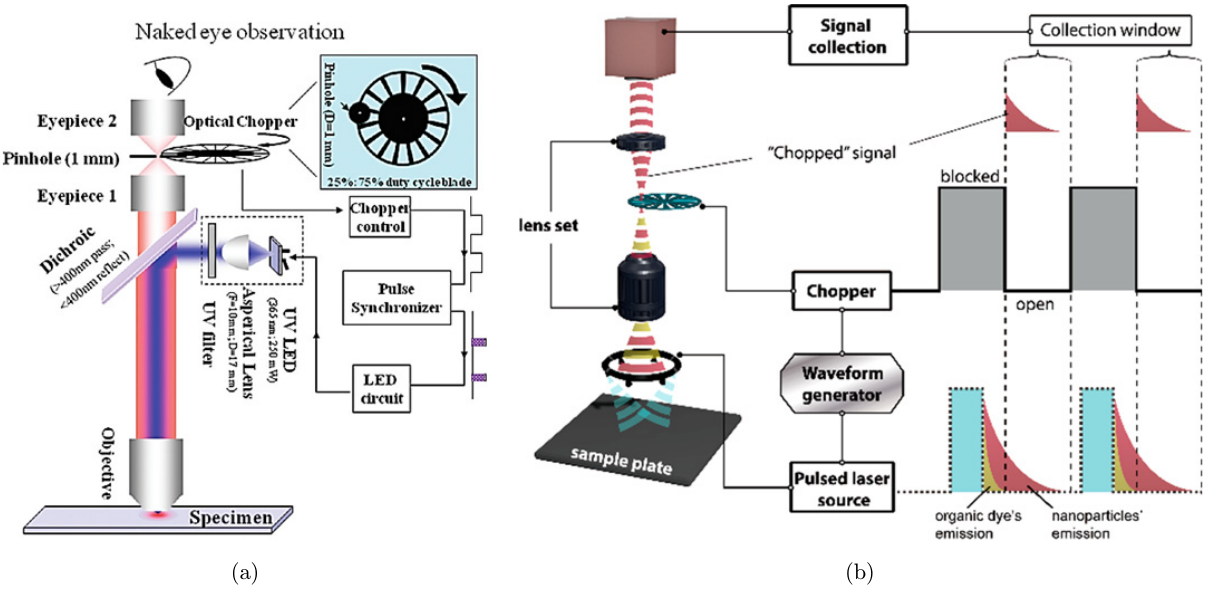
Fig. 5. Example of OC-(iii). (a) Synchronization output was provided by the clock signal from the chopper controller, producing TTL signals to trigger the UV LED circuit, so that an appropriate TG delay can be achieved. (b) Synchronization output was provided by the waveform generator, producing TTL signals that were synchronized with the chopper and were used to synchronize the laser source. An appropriate TG delay can be achieved by setting parameters such as the duty cycle and the initial phase of the TTL signals. Reprinted with permission from Refs. 32 and 48.